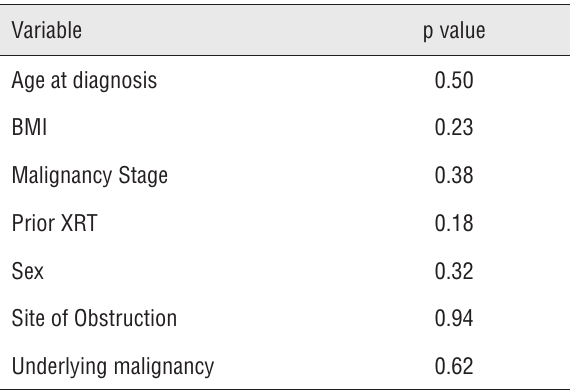
Table 3 - Predictive factors of metallic stent failure with p-values.